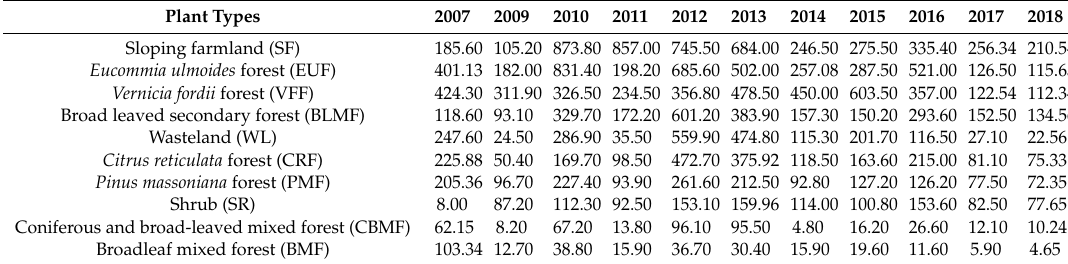
Table 3. Contribution to runo ff generation due to di ff erent vegetation covers (t / hm 2 ).